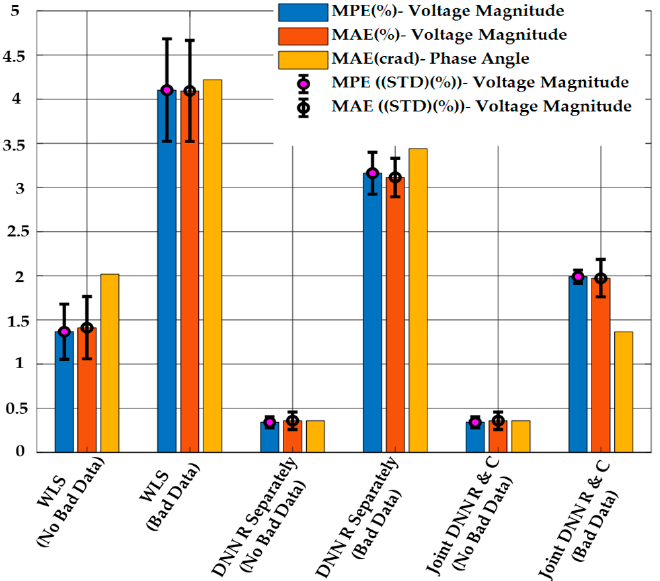
Figure 8. DSSE Results Obtained Using the Proposed Method, the Regression-only DNN Model, and WLS with or without Bad Data when N a = 600 ( 5% ) and z a = ∼ N ( µ z , σ z )